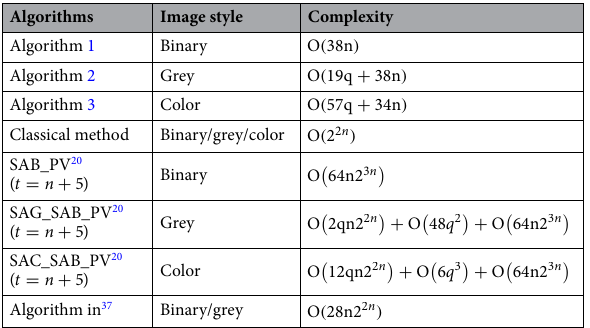
Table 2. Complexity of different quantum methods for comparing the similarity between two quantum images based on NEQR and its variant. The complexity of image preparation is not contained in this table.